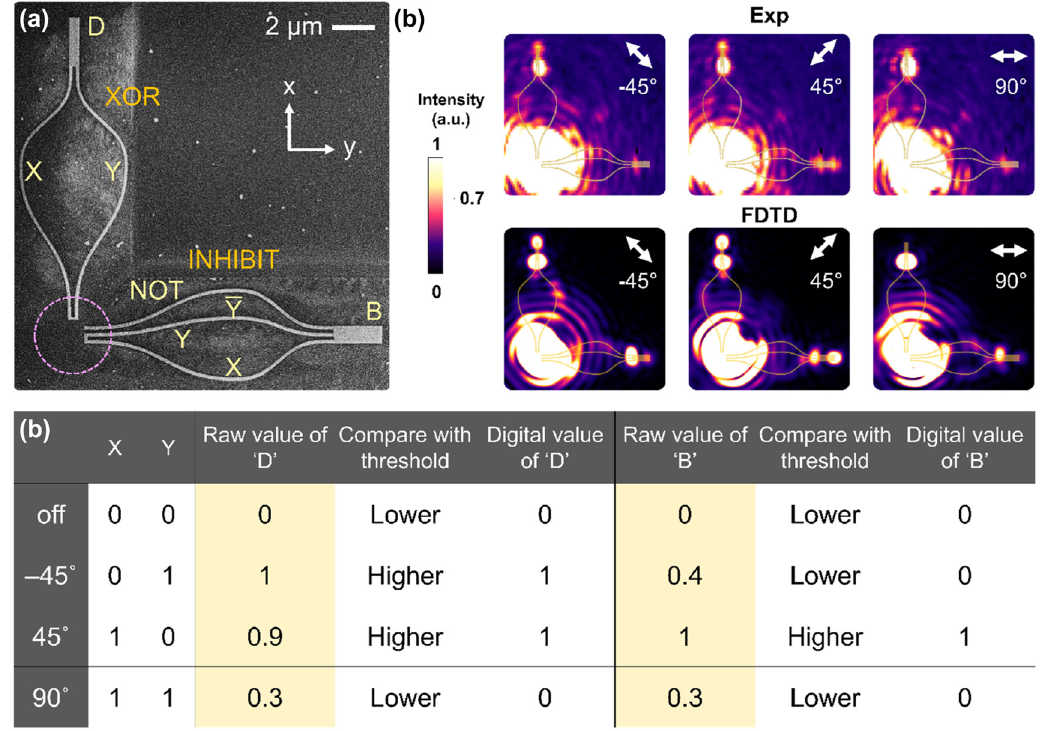
Figure 3: The plasmonic half-subtractor. (a) The SEM image of the half-subtractor for the operation Y–X. The dashed circle denotes the input laser beam position. (b) Experimental (Exp) and simulation (FDTD) results. For − 45 ◦ polarization, the output of the XOR circuit is above limiter threshold, leading to ‘D’ of ‘1’; the output of the INHIBIT AND circuit is below threshold, giving a borrow ‘B’ of ‘0’. This result lead to Y–X = 1. For 45 ◦ polarization, the outputs of the XOR and INHIBIT AND circuit are both above limiter threshold. This results in Y–X = − 1. For 90 ◦ polarization, outputs of the XOR and INHIBIT AND circuits are both below limiter threshold, resulting in Y–X = 0. (c). The truth table of the experimental plasmonic half-subtractor. Raw intensity values and the determined binary values are both